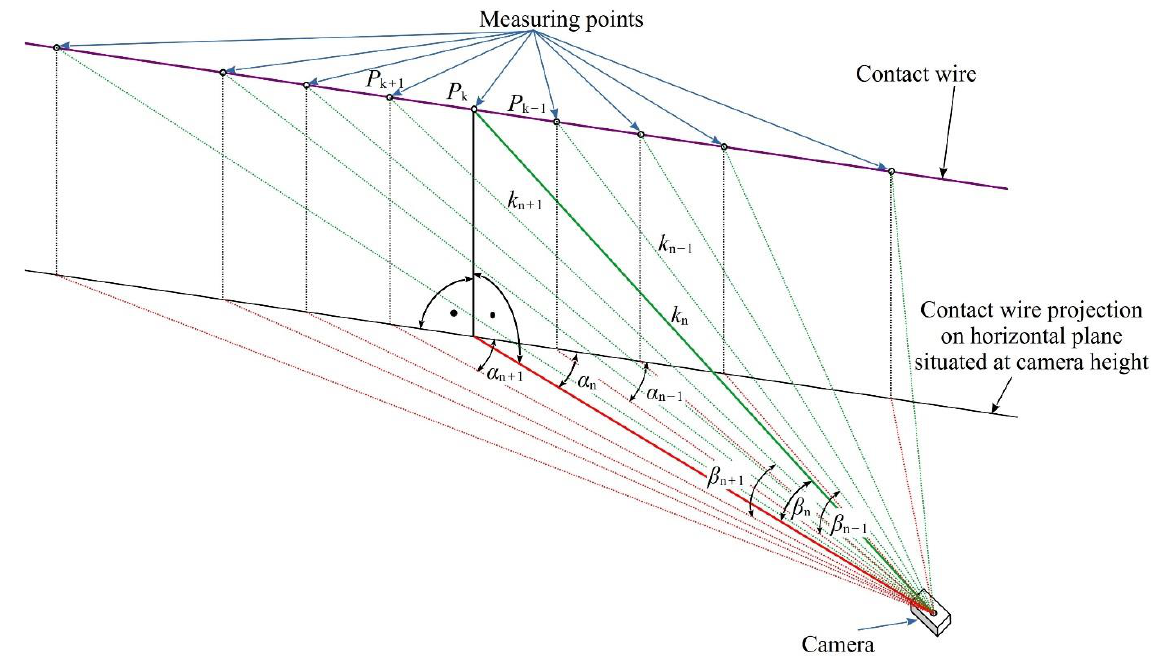
Figure 7. The principle of position monitoring of light points P k on the contact wire in 3D space using 2D imaging camera.